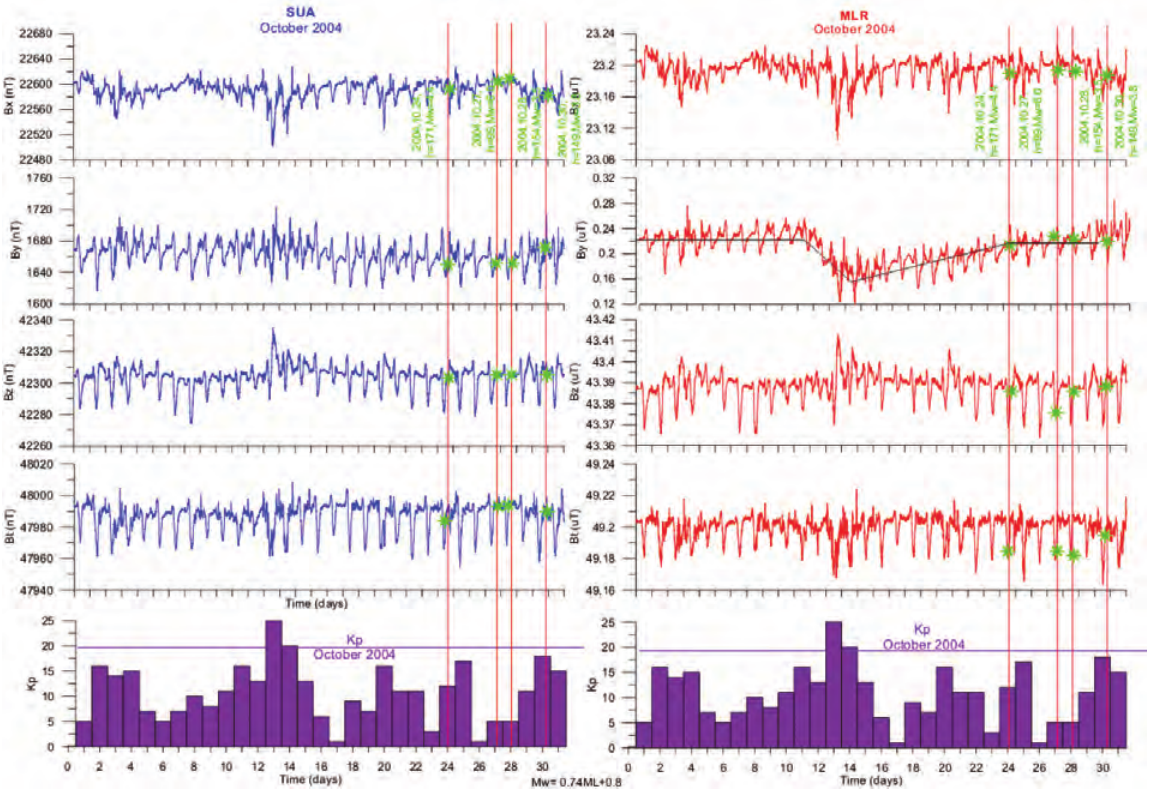
Figure 8. The V-shaped anomaly recorded on the horizontal component By of the MLR Observatory data prior to the Mw = 6.3 (October 27, 2004) intermediate depth Vrancea